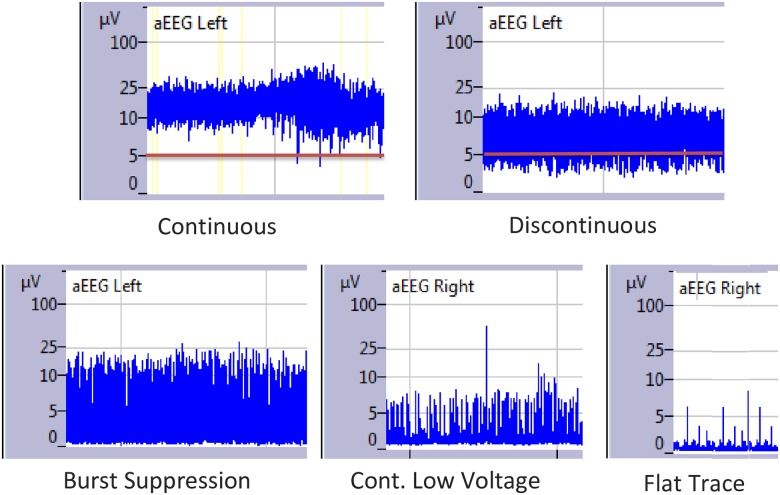
Examples of aEEG background patterns.